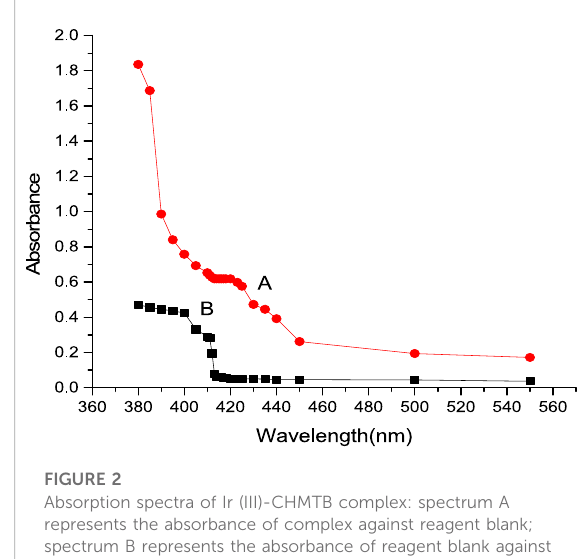
FIGURE 2 Absorption spectra of Ir (III)-CHMTB complex: spectrum A represents the absorbance of complex against reagent blank; spectrum B represents the absorbance of reagent blank against solvent (pure